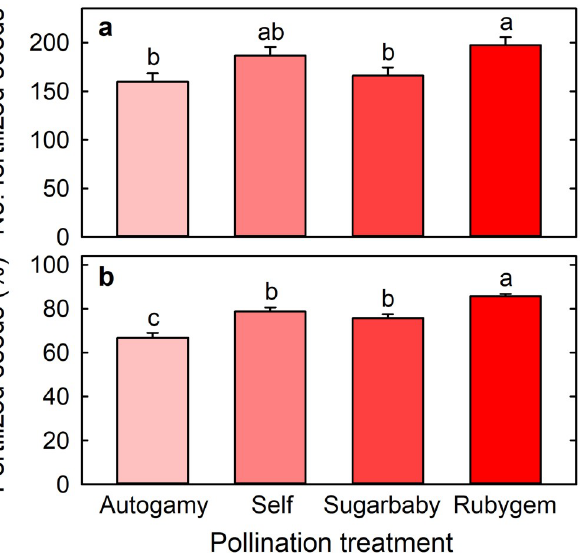
Fig 6. (a) Number of fertilized seeds and (b) percentage of seeds that are fertilized on Redlands Joy strawberry fruit arising from unassisted self-pollination (Autogamy) or hand-pollination with self-pollen (Self) or cross- pollen from another cultivar (Sugarbaby or Rubygem). Means + SE with different letters are significantly different (GLM; P < 0.05; n = 100